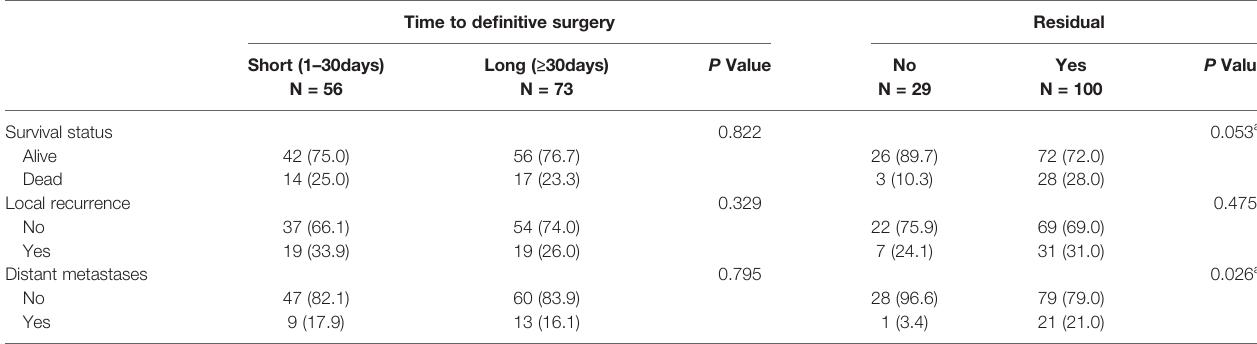
TABLE 5 | Oncologic outcomes for the unplanned excision